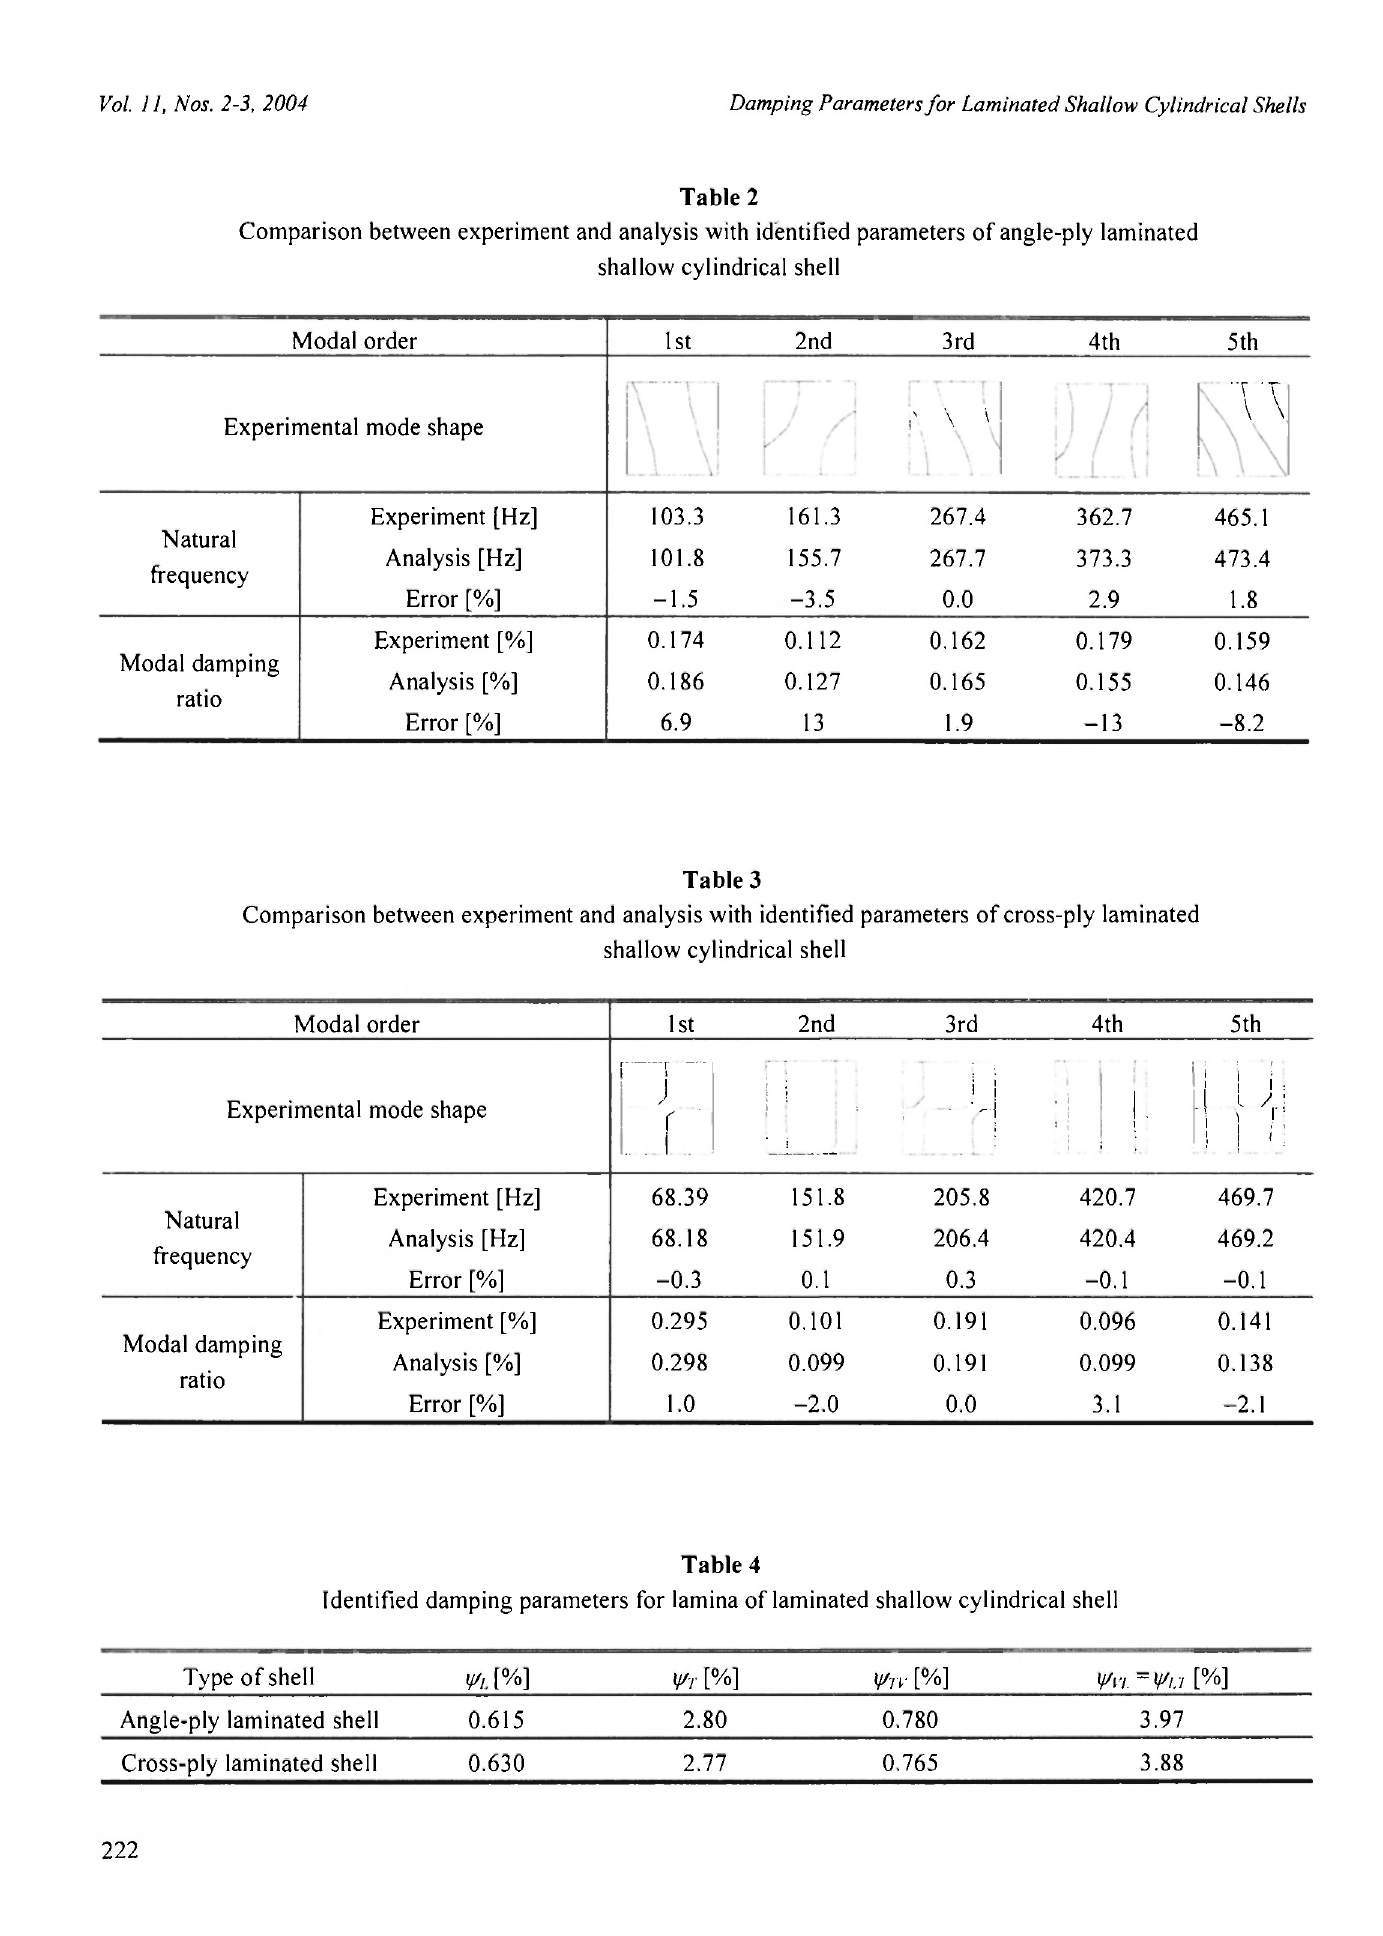
Comparison between experiment and analysis with identified parameters of angle-ply laminated shallow cylindrical shell